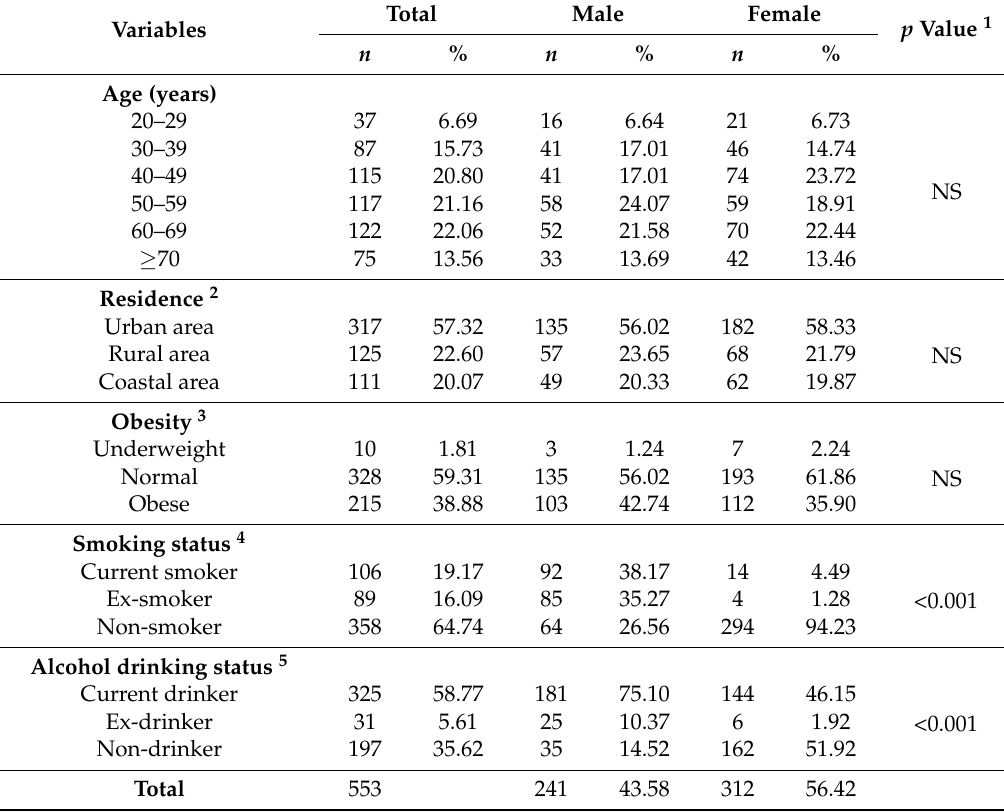
Table 1. General characteristics of the study population by classification